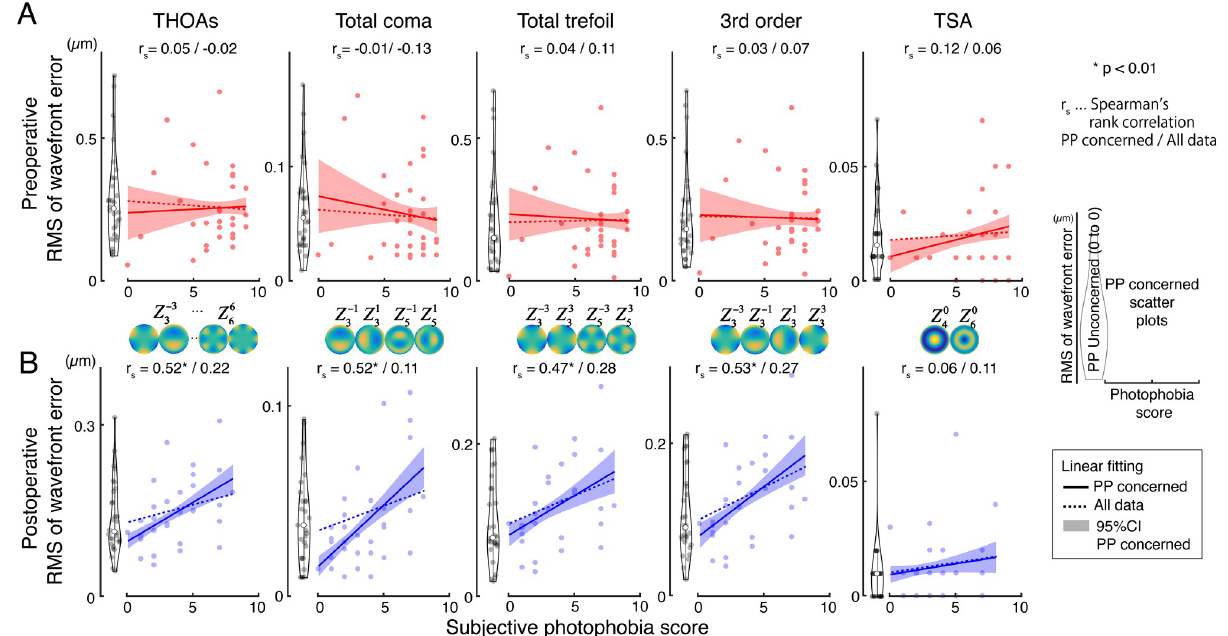
Fig 3. Correlation between RMS of wavefront errors and photophobia score. (A) Preoperative and (B) postoperative data are shown. The vertical axis represents positive root-mean-square (RMS) values of wavefront errors. The horizontal axis represents the subjective photophobia score. The distribution of RMS values in 30 cases (PP unconcerned) with a photophobia score of 0 both pre and postoperatively are shown using a violin plot on the left side of each graph. RMS data of other 32 cases (PP concerned) are plotted using red and blue circles. The solid line indicates linear fitting with PP concerned patients and dashed line indicates linear fitting with all of 62 eyes. The shaded area represents the 95% confidence interval of the linear fitting for PP concerned patients. Spearman’s rank correlation (r s ) in the PP concerned cases and all cases is shown on the left and right side, respectively. (A) All five combinations of photophobia score and RMS data show no significant correlation. (B) Four components (THOAs: total higher-order aberrations, total coma, total trefoil, and third-order groups) show significant positive moderate correlations with photophobia score. TSA: total spherical